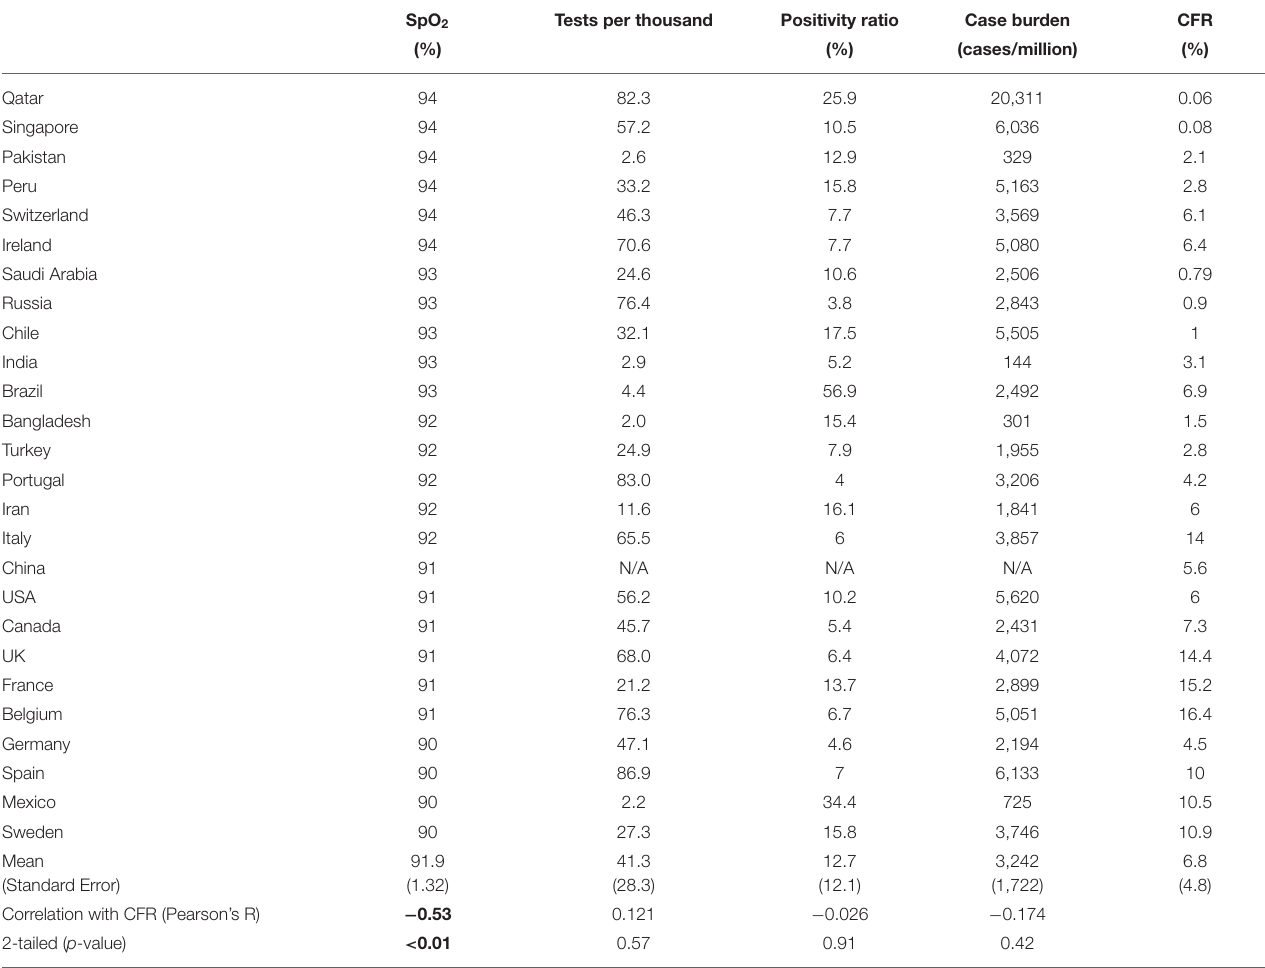
TABLE 1 | National CFR, target SpO 2 , and potential testing confounders in 26